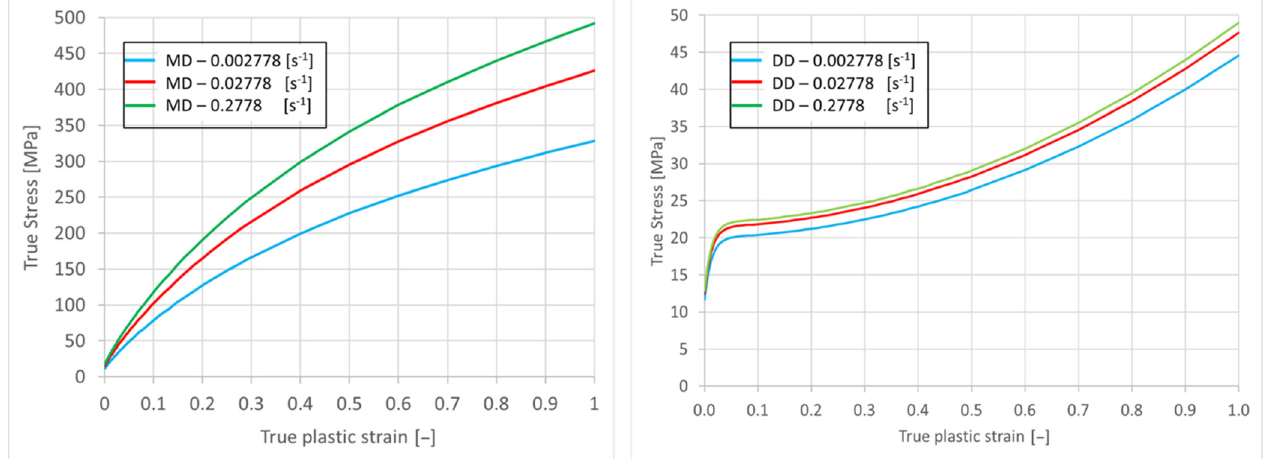
Figure 13. Strain rate dependent, orthotropic, hardening true stress vs. true plastic strain curves fitted to test results for MD (0°) direction ( left side ) and derived from tests provided in DD (45°) direction ( right side ).